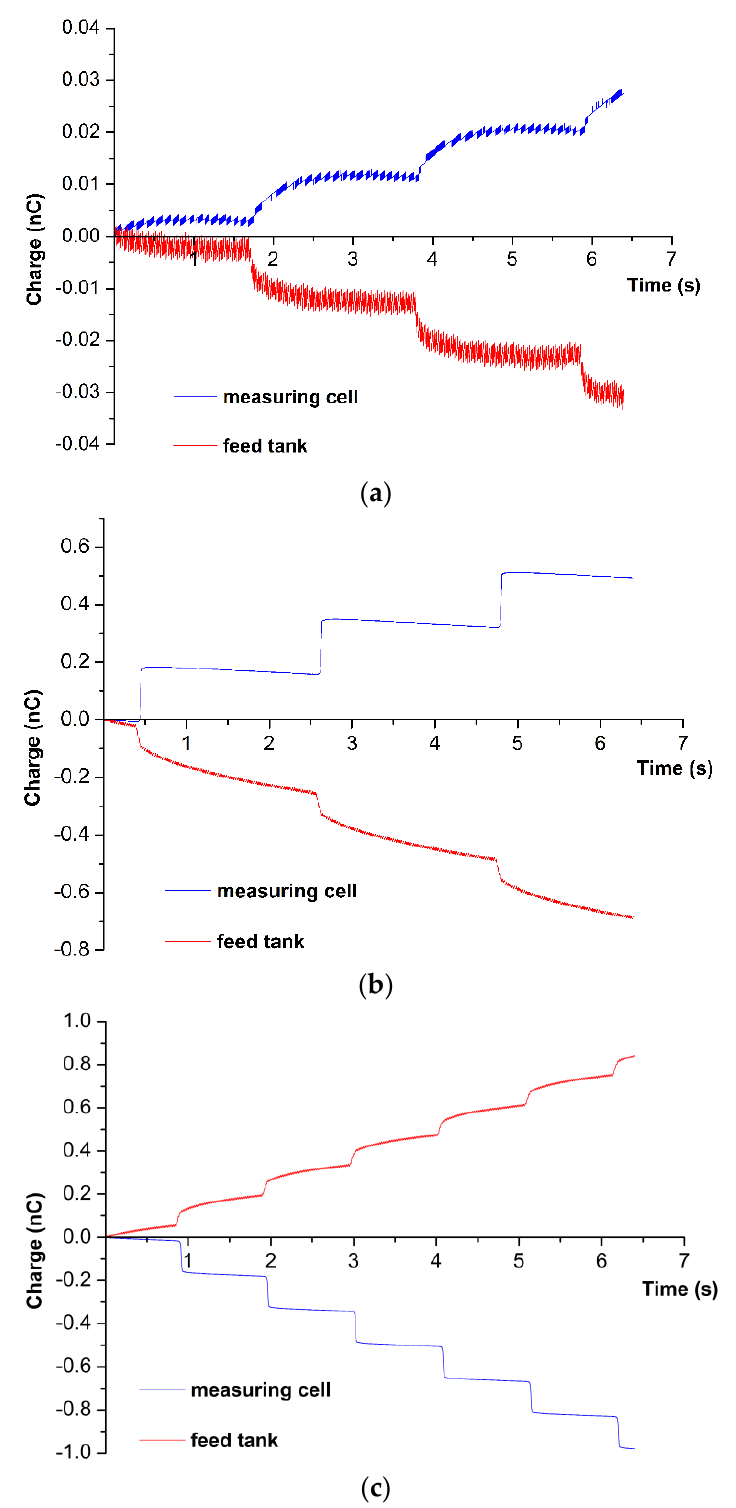
Figure 4. Experimentally obtained time dependencies of the charge entering the measuring cell with the water droplets (blue) and returning to the feed tank (red) at various voltages applied to the ring: 0 V ( a ), − 3 kV ( b ), and +3 kV ( c ).